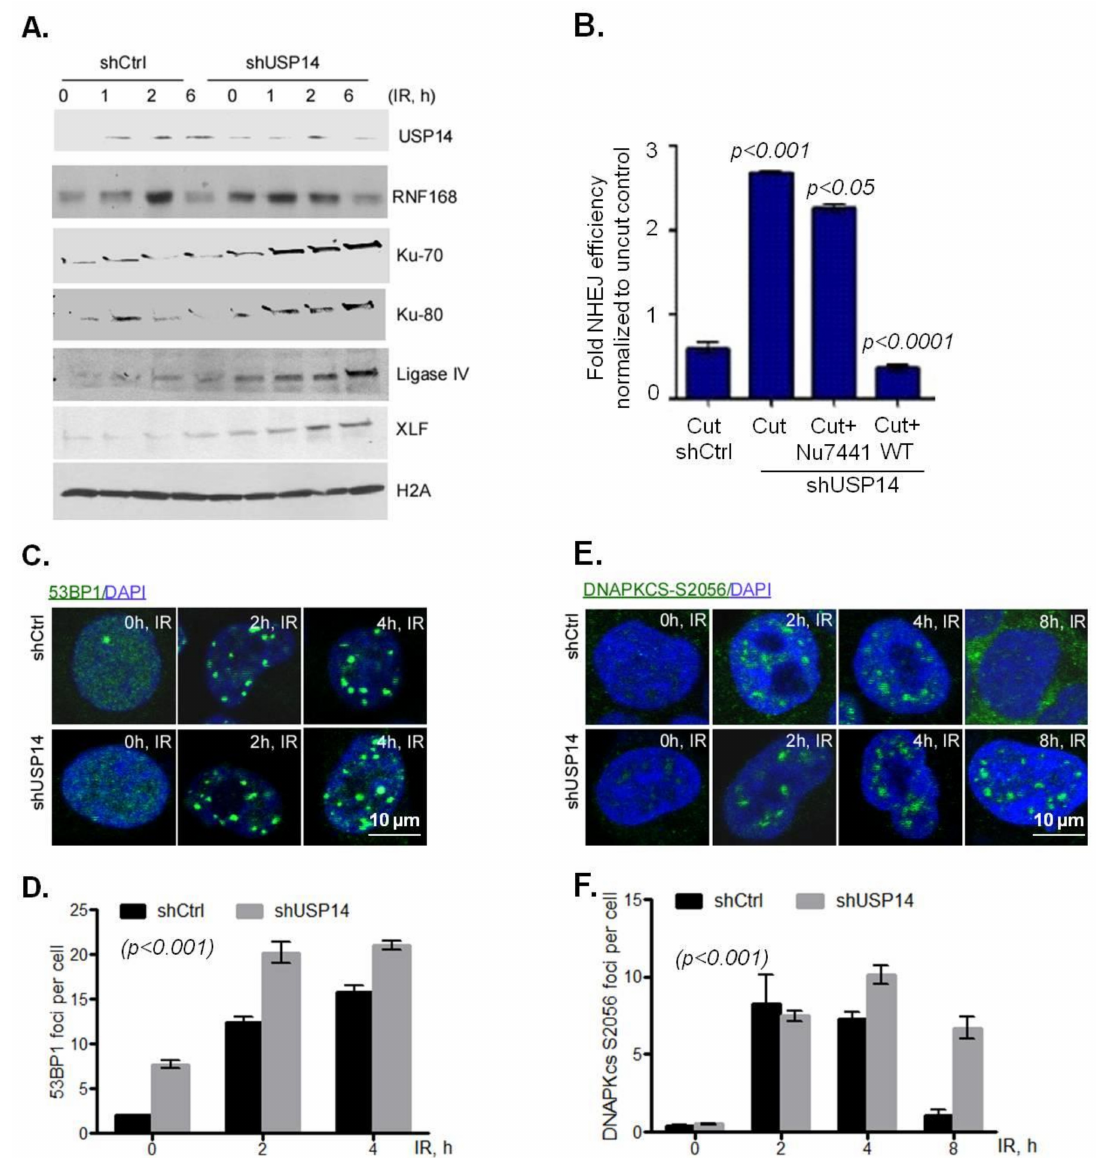
Figure 4. USP14 disrupts the non-homologous end joining (NHEJ) DNA damage response (DDR) in NSCLC cells. ( A ) Chromatin recruitment of the indicated proteins in H460 cells following IR +/ − IU1 treatments at the indicated time points. H4 was used as loading control for the chromatin-bound fraction. ( B ) NHEJ measured by a plasmid luciferase repair assay. Data are normalized for transfection e ffi ciency and then to uncut luciferase plasmid. Confocal immunostaining and graphical representation of quantitation of ( C , D ) 53BP1, and ( E , F ) DNA-PKCs S2056 at the indicated time points following 5Gy IR treatment in shControl (shCtrl)- vs. shUSP14-expressing A549 cells. Nuclei were stained with DAPI. Data shown are the means ± SEM ( n =